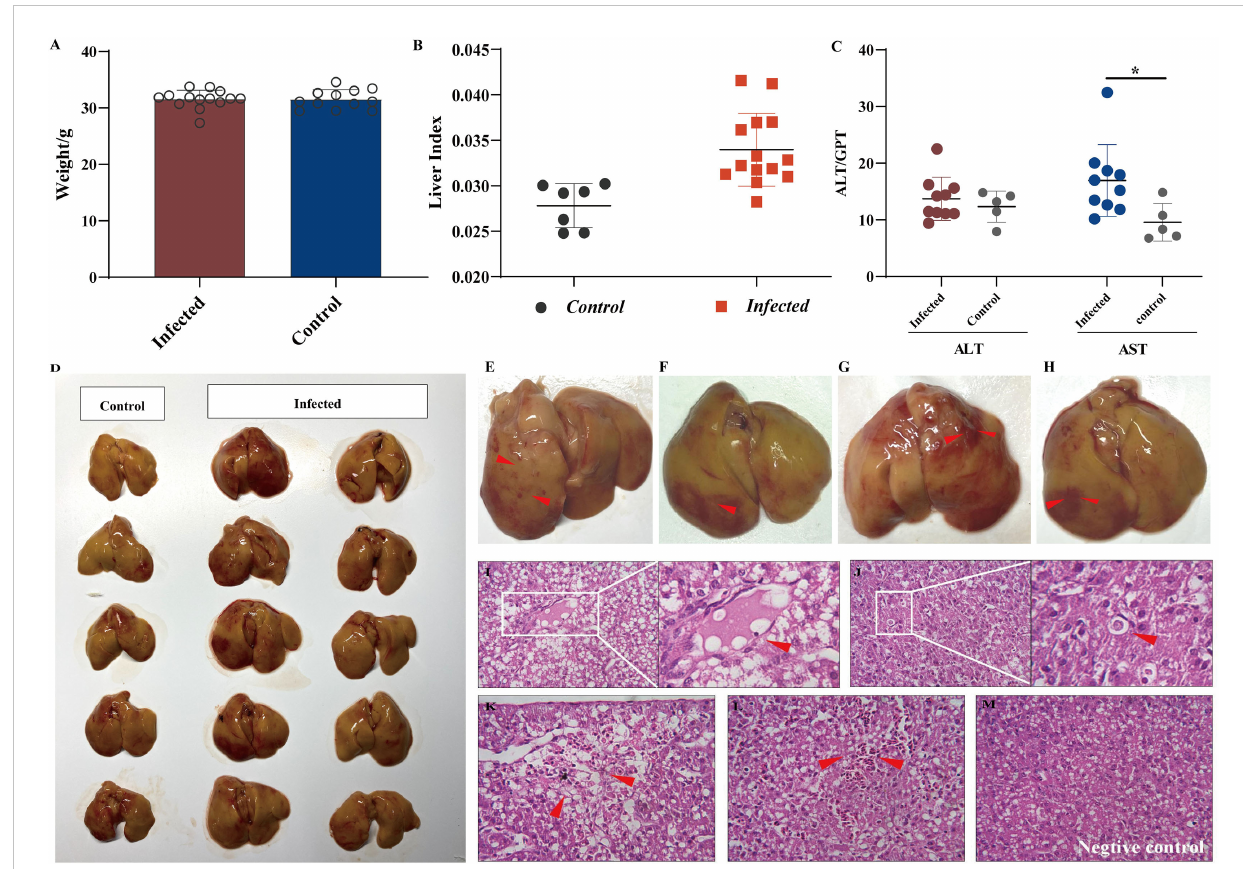
FIGURE 1 Liver injury analysis in chicken infected with aHEV. (A) Analysis of weight data. (B) Liver to body weight ratio was calculated by (liver weight)/(body weight) × 100%. (C) ALT levels and AST levels in SPF chickens experimentally infected with YT strain or saline. (D) Gross lesions in the liver in the negative control group: no obvious pathological signs were seen, and the liver was normal in color. (E – H) Livers from the inoculated chickens showed enlargement and subperitoneal hemorrhage. Livers from the infected group exhibited severe lesions (red arrow) including thrombosis (I) , apoptotic bodies (J) , hemorrhage and hepatocellular necrosis (K) , and congestion (L) . (M) Liver from negative control group showing no visible lesions. Tissues were stained with hematoxylin and eosin (stained sections were imaged at ×40). Symbols indicate comparison vs. control group; *P <